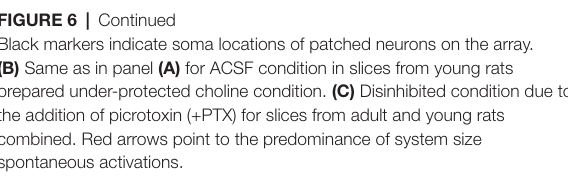
FIGURE 6 | Continued Black markers indicate soma locations of patched neurons on the array. (B) Same as in panel (A) for ACSF condition in slices from young rats prepared under-protected choline condition. (C) Disinhibited condition due to the addition of picrotoxin (+PTX) for slices from adult and young rats combined. Red arrows point to the predominance of system size spontaneous activations.